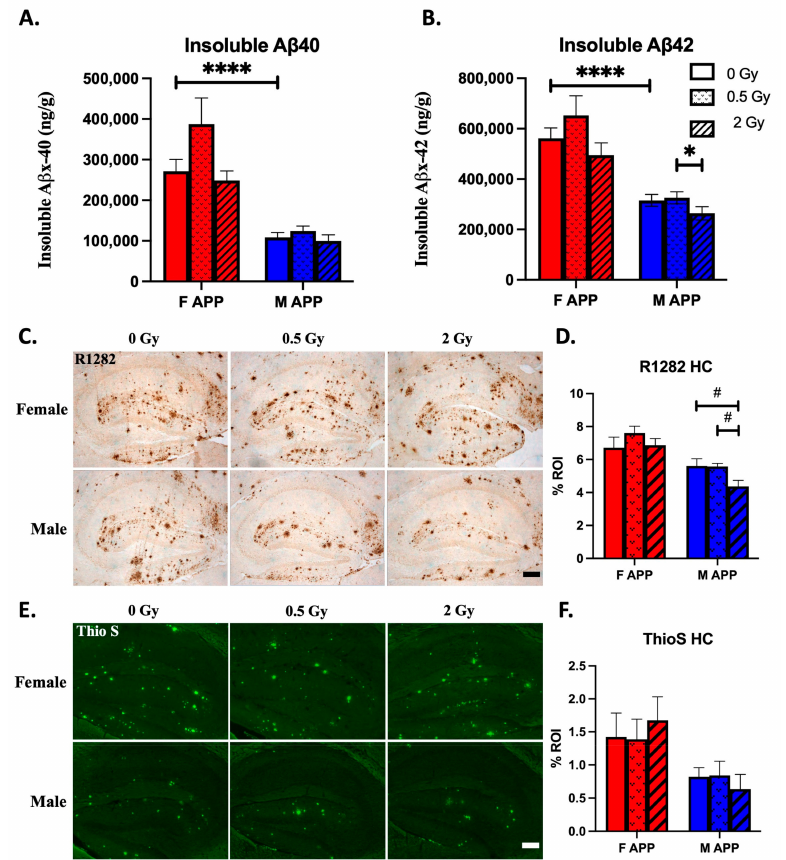
Figure 4. Proton irradiation may have modestly reduced cerebral A β levels in Tg male mice, but no change in Tg females was observed. ( A , B ): Insoluble A β x-40 and A β x-42 levels were quan- tified by an MSD 4G8 A β -triplex ELISA from hemibrain homogenates ( n = 10–16 mice/group). ( C , D ): R1282 immunohistochemical (IHC) staining and quantification of hippocampal beta-amyloid ( n = 8 mice/group). ( E , F ): Thioflavin S staining and quantification of fibrillar protein aggregates in the hippocampus ( n = 7–8 mice/group). Scale bars: 100 µ m. #: p < 0.1, *: p < 0.05, ****: p < 0.0001. Data were analyzed by 1-way ANOVA within sex (after failing parametric assumptions for 2-way ANOVA) followed by post-hoc multiple pairwise comparisons using Tukey’s correction. ELISA quantification of A β 42 in males violated ANOVA assumptions of normality and was analyzed with a nonparametric Kruskal-Wallis test followed Dunn’s multiple comparisons test. Unirradiated control groups were compared by planned, 2-tailed t-tests independent of